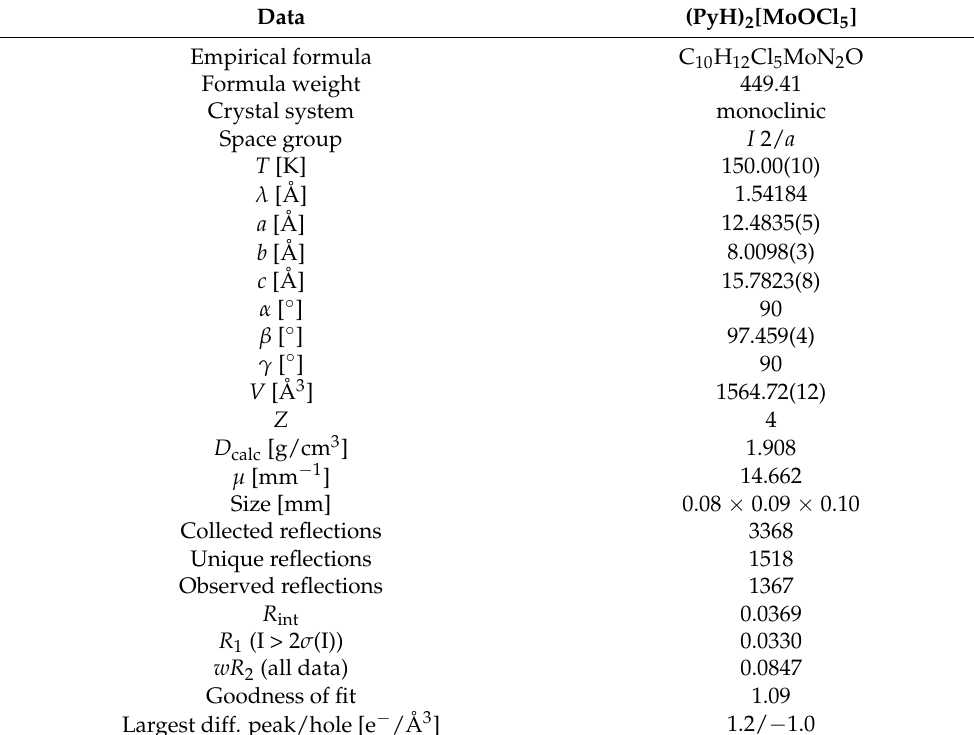
Table 3. Crystallographic data for (PyH) 2 [MoOCl 5